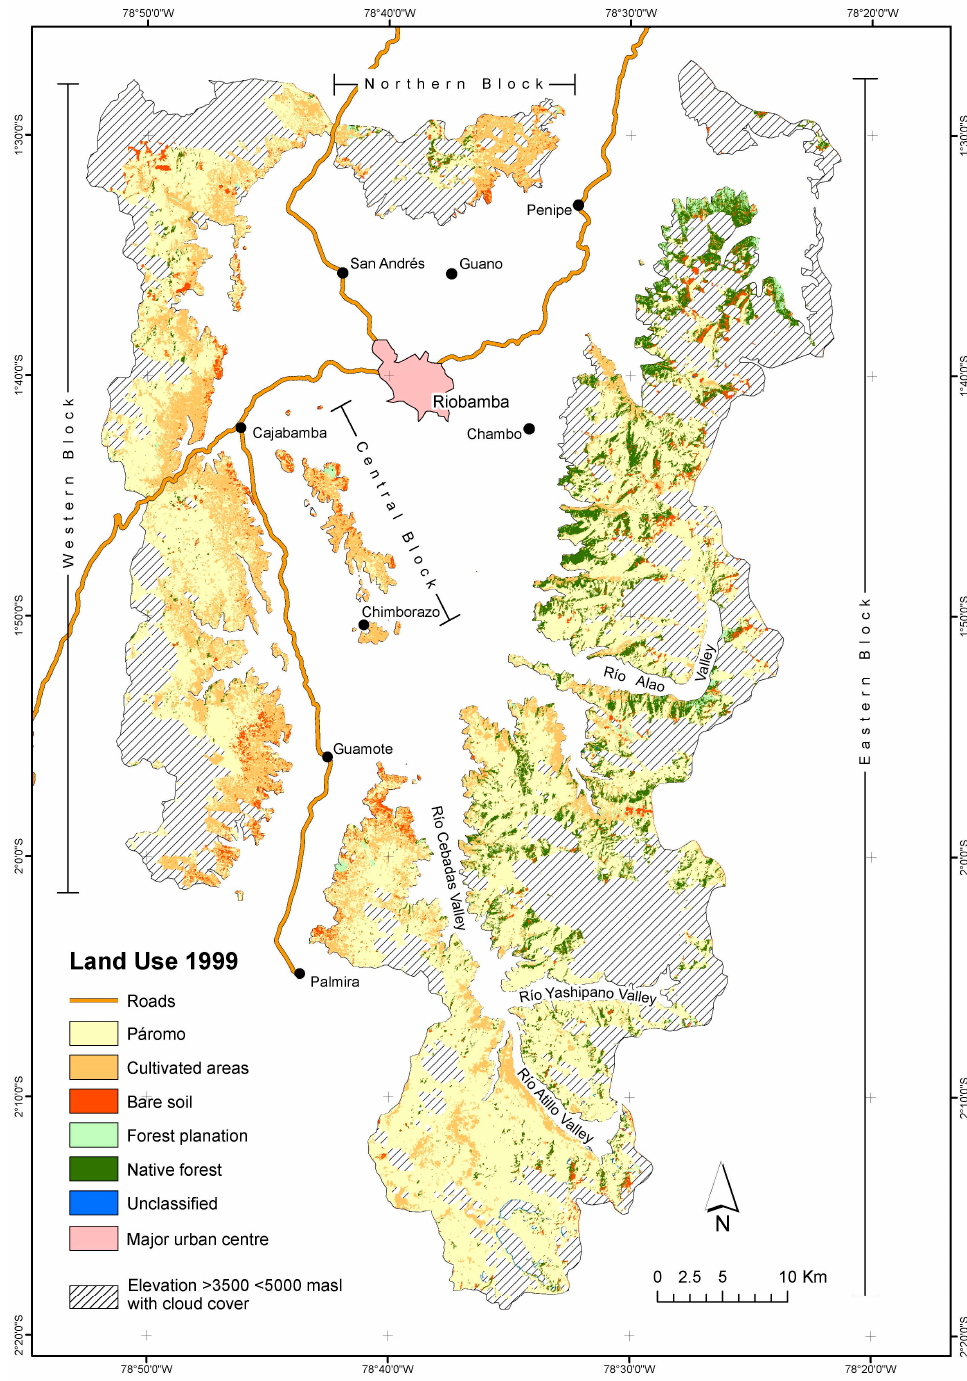
Figure 4. Chambo Basin: land-use, 1999.